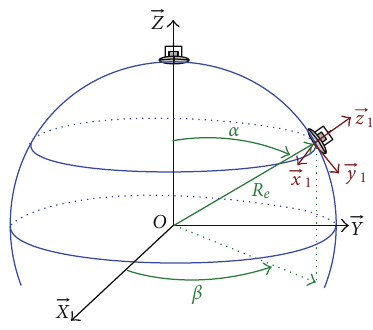
Figure 4: Global coordinate system for ship positions.